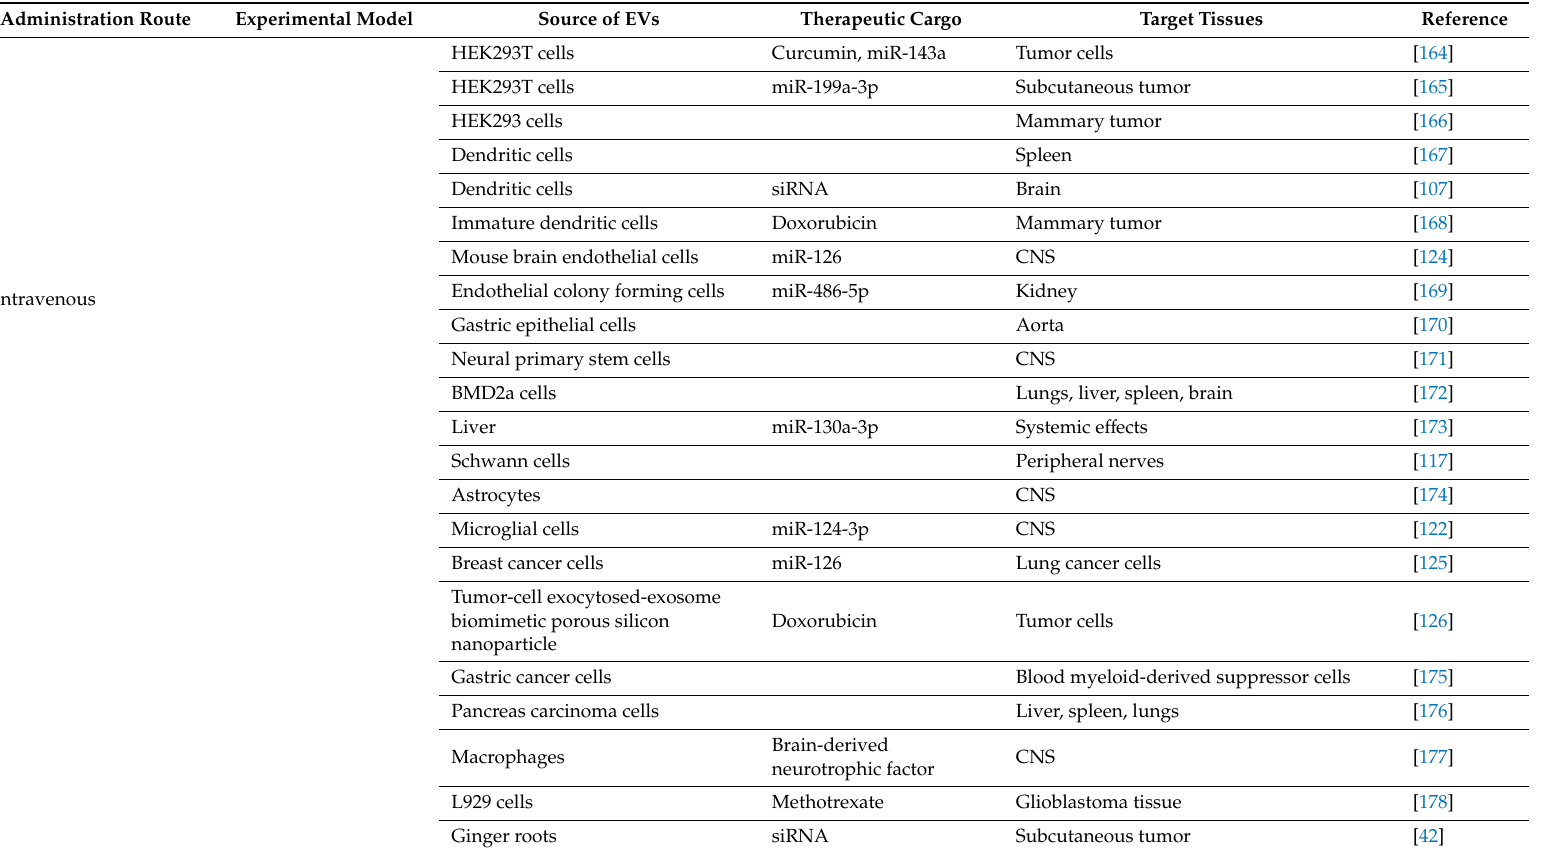
Table 2. Administration routes for EVs in vivo. Detailed are di ff erent studies using in vivo models where EVs were administered. Described are the administration routes, the experimental model, the source of EVs, the therapeutic cargo (when known), and the target tissue of the EVs or the EV-related e ff ects. While in some cases a therapeutic cargo was known, in other cases the EV itself was the therapeutic agent and no particular component of the cargo was specified as responsible for the e ff ect observed. Abbreviations: AdSC: adipose tissue-derived stem cells; CNS: central nervous system; miR: micro RNA; MSC: mesenchymal stem